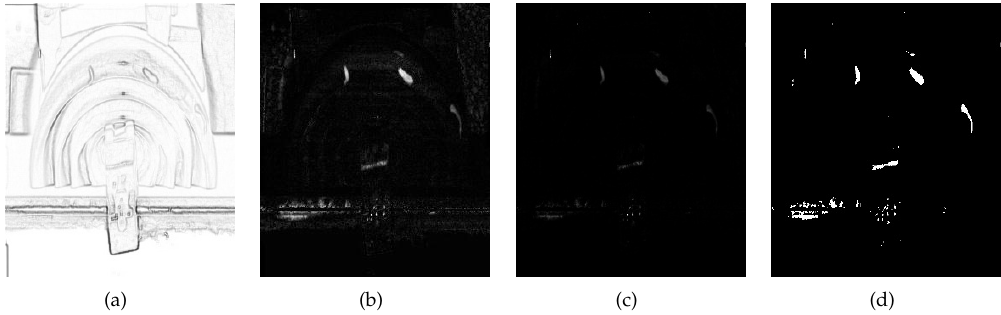
Figure 10. ( a ) Weight for reduction of the common high-frequency components; ( b ) multiplication result of ( a ) with the subtraction result; ( c ) Weber contrast of ¯ g b candidate image. Note that ( b – c ) were expressed by normalizing the original